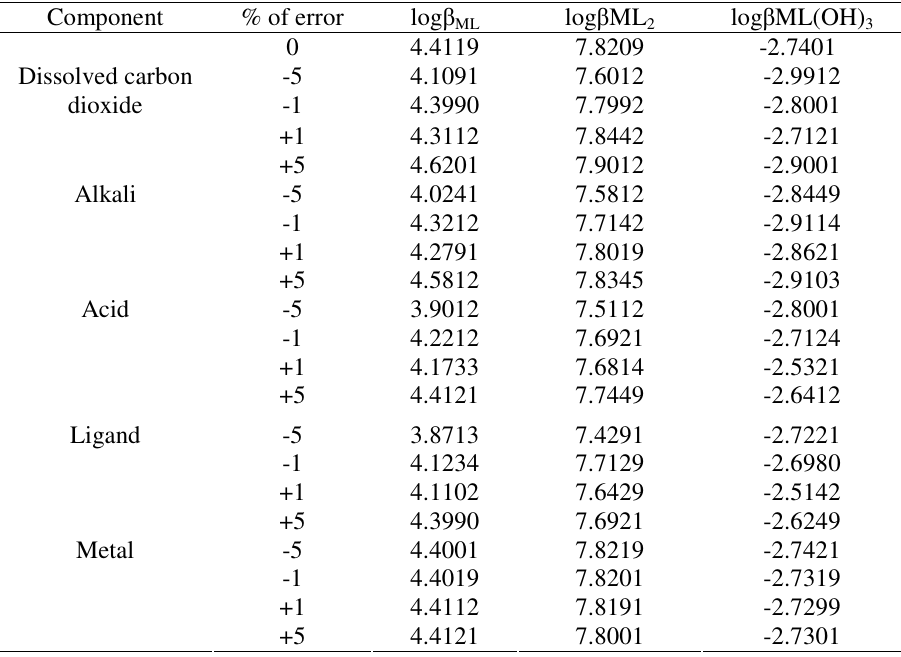
Table 4. Effect of systematic errors of La(III)-2-oxo-1-pyrrolidine acetamide Equilibrium in 10% v/v dioxane–water